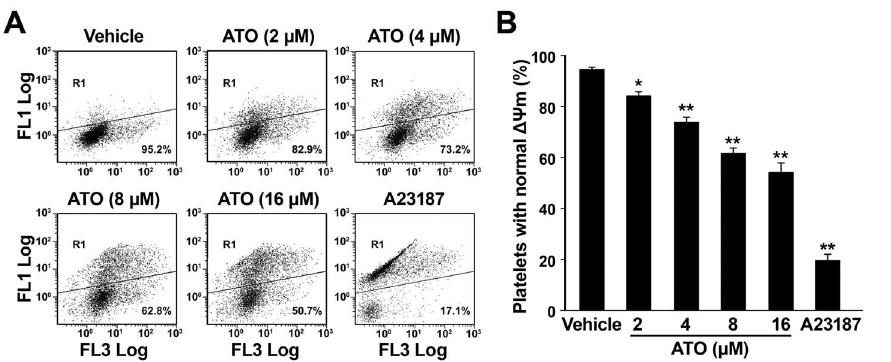
Figure 1. ATO dose-dependently induces DY m depolarization in platelets. Washed platelets were pre-treated with 2, 4, 8, or 16 m M of ATO or vehicle at 37 u C for 5 hrs. JC-1 was added into the pre-treated platelets to a final concentration of 5 m g/mL and then incubated at 37 u C in the dark for 20 min. Then the treated samples were detected using flow cytometry. (A) Typical flow cytometric histograms represented of 3 separate experiments are shown. FL1 and FL3 stand for green and red fluorescence, respectively. Dots inside R1 indicate that platelets are out of the main population, bearing DY m depolarization. (B) Quantitation data from 3 separate experiments with different donors are illustrated (mean 6 SD). * P , 0.05, ** P , 0.01, compared with vehicle controls.